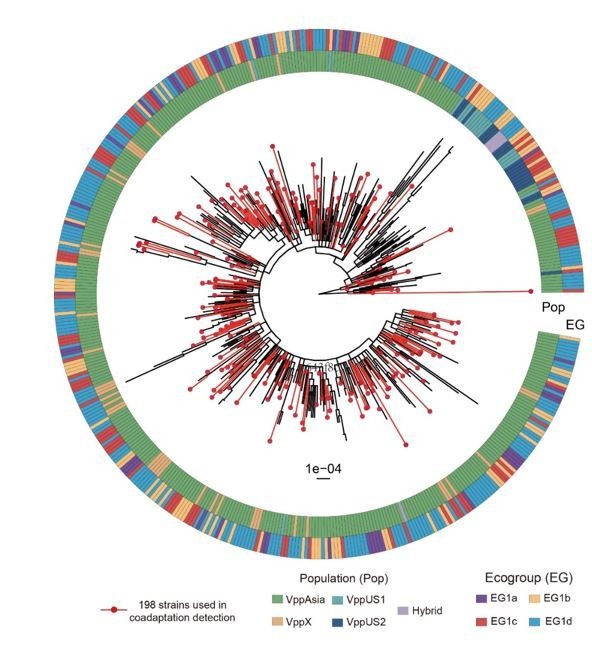
Maximum likelihood tree of 469 non-redundant strains based on 53 concatenated ribosomal gene nucleotide sequences.Red branches indicate strains in the discovery dataset. The colored circles indicate populations (inner) and ecogroups (outer) according to the legend.